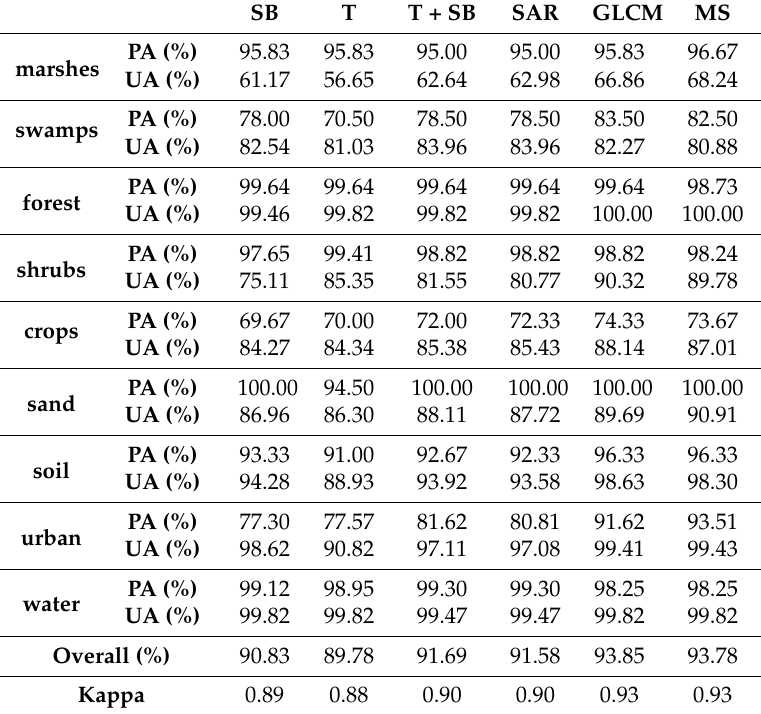
Table 6. The User’s (UA) and Producer’s (PA) accuracies for all classes in the best scenario of each group. The six groups are: SB (Spectral Bands); T (Transformations); T + SB (Transformations +